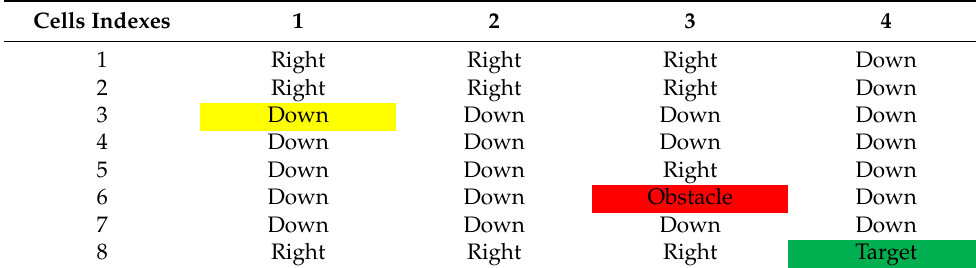
Table 1. The best actions provided by the Q-learning algorithm for each cell. Cells